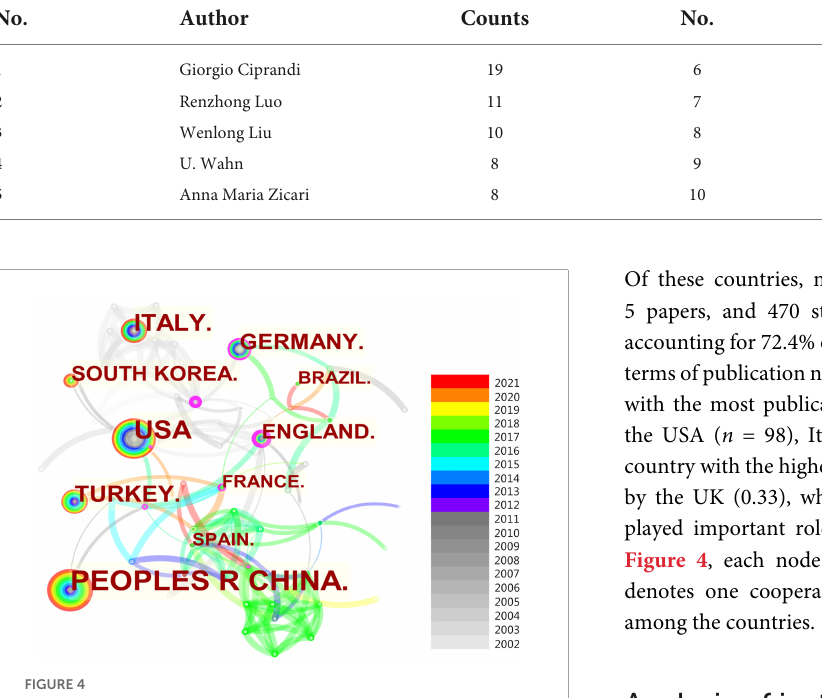
FIGURE4 Collaborating Countries on AR research in